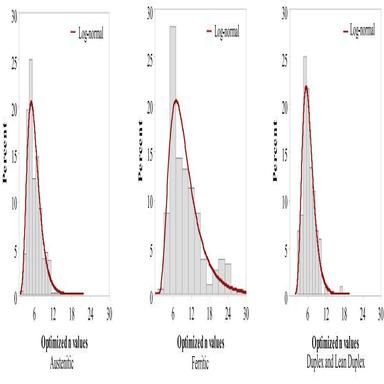
Histograms of strain hardening exponent n for different cold-formed stainless steel types.